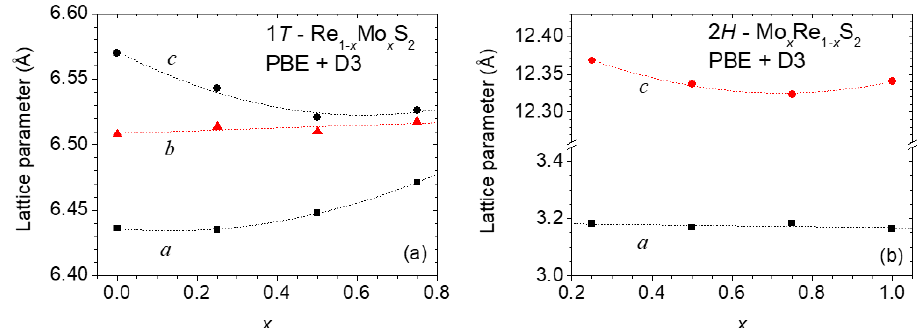
Figure 2. ( a ) Lattice parameters obtained with PBE+D3 calculations for the 1T-(Re,Mo)S 2 solid solu- tion as a function of Mo content ( x ); ( b ) Lattice parameters obtained with PBE+D3 DFT calculations for the 2H-(Mo,Re)S 2 solid solution as a function of Mo content ( x ).